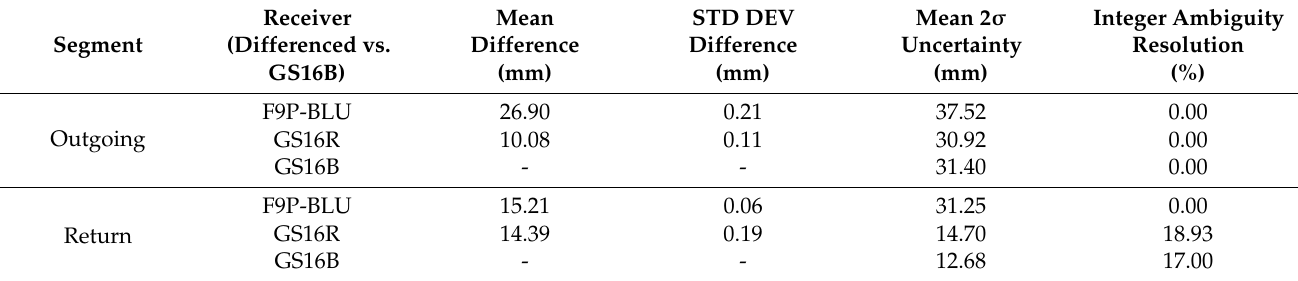
Figure 23. Dataset C ZWD profile with data split in the middle. Local time is UTC − 6:00. Table 7. Dataset C ZWD and profile mean differences, standard deviations, average 2 σ uncertainties and integer ambiguity resolution success rates for split outgoing and return